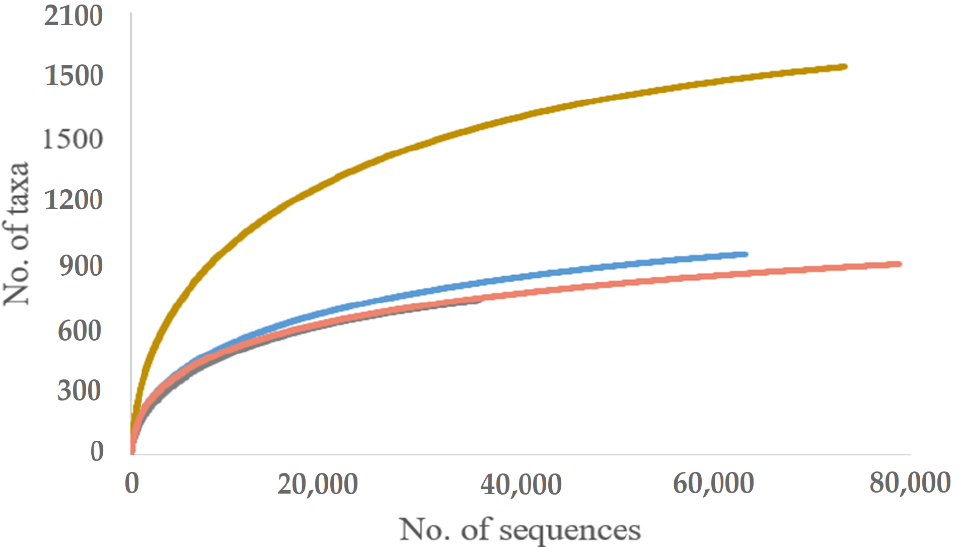
Figure 4. Species accumulation curves showing the relationship between the cumulative number of fungal OTUs and the number of ITS rRNA sequences shown as Yellow — Soil, Orange — Needles, Blue — Shoots, and Gray — Roots.